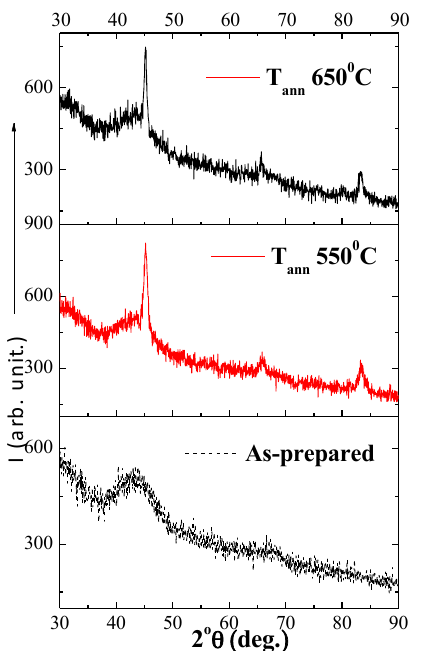
Figure 6: XRD patterns of as-prepared and annealed at different temperature for 1 hour Fe Cu Nb Si B 70.8 1 3.1 14.5 10.6 microwires.